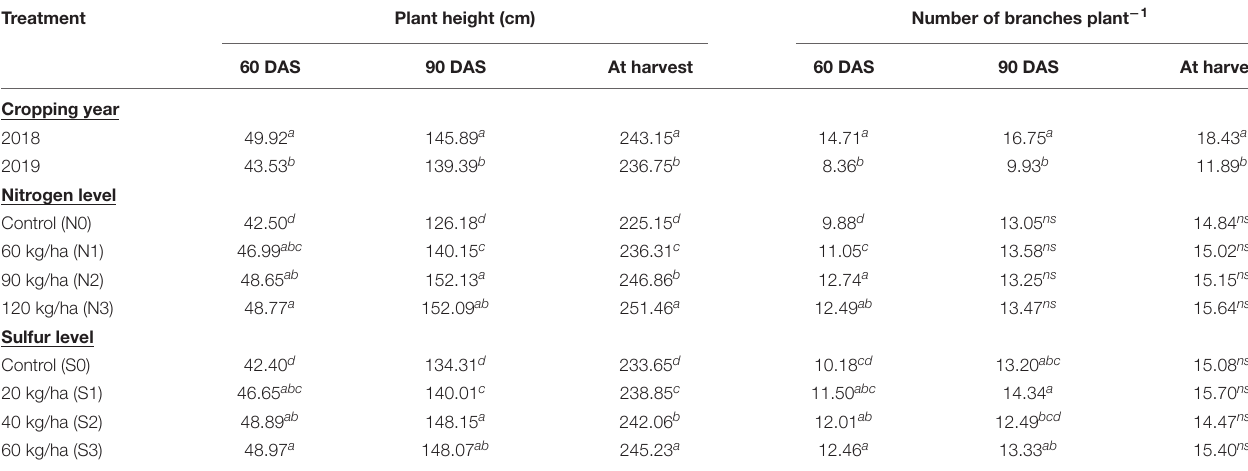
TABLE 2 | Effect of year and fertilization levels on growth parameters of T. minuta at different growth stages.